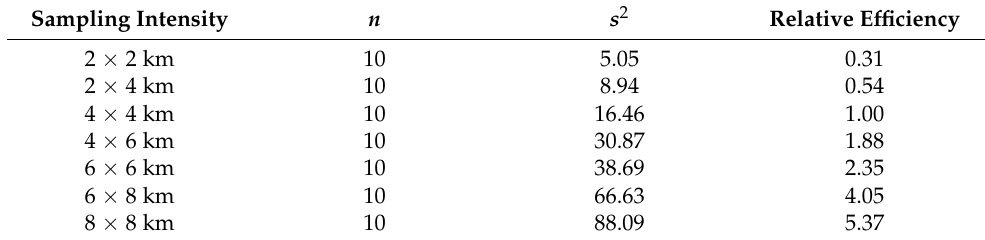
Table 5. Comparison of relative efficiency estimates by sampling intensity.